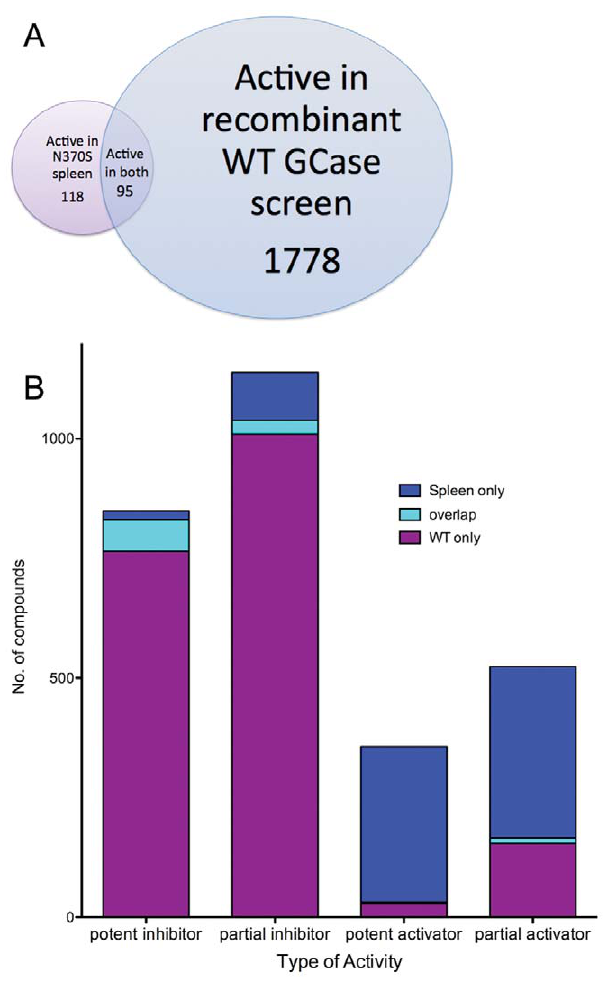
Figure 7. Comparison of the active compounds identified in the WT and N370S HTS experiments. A. Distribution of active compounds in the WT (blue) and N370S/N370S spleen (red) HTS experiments. B. Overlap between active compounds tested in both experiments by type of activity.